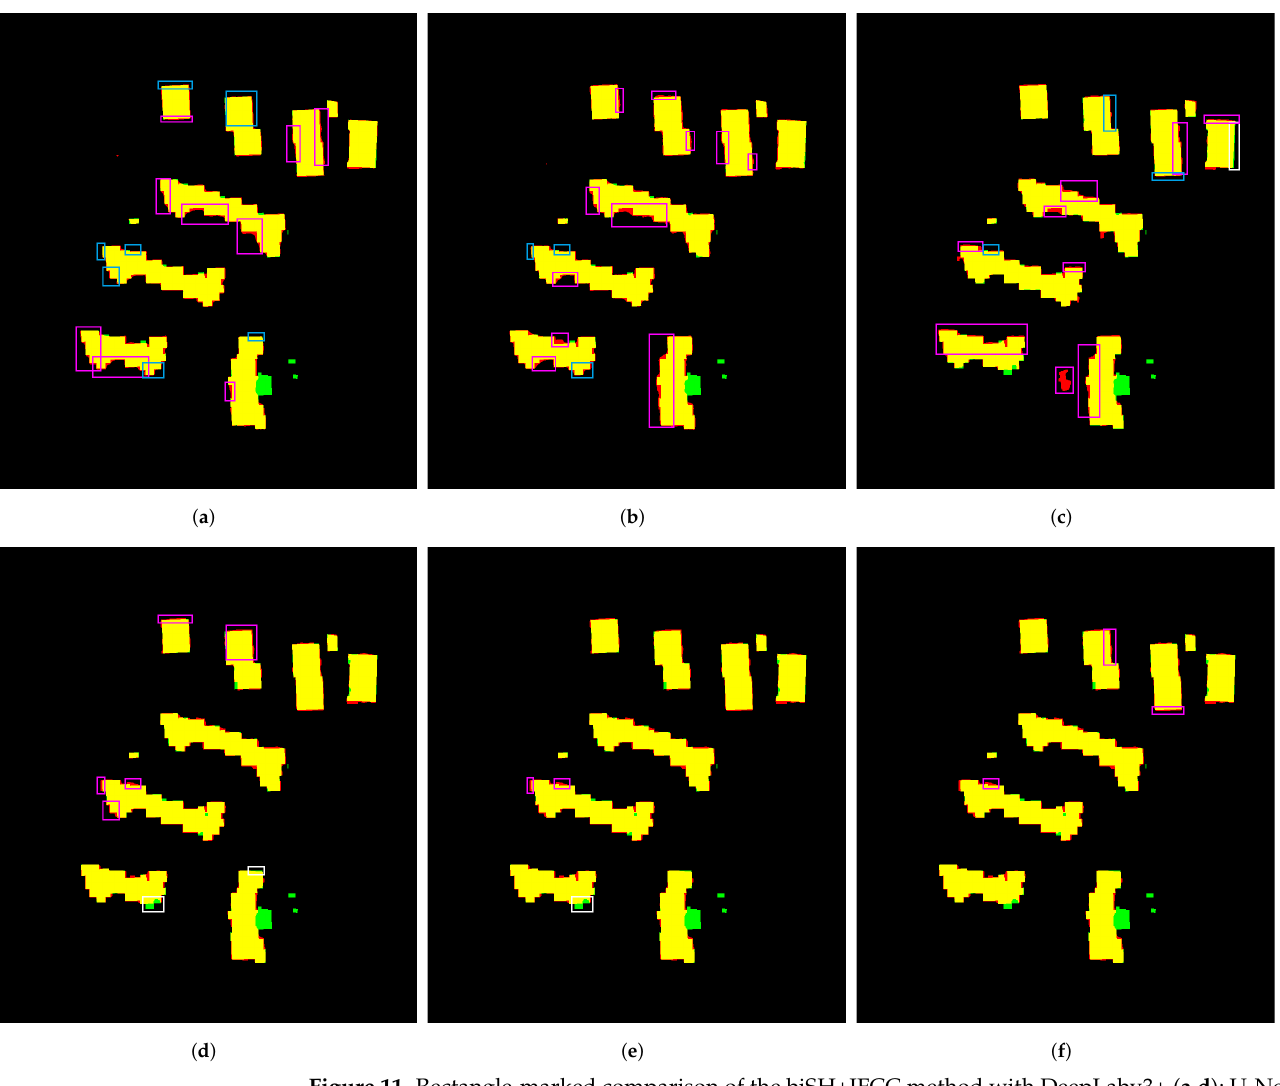
Figure 11. Rectangle-marked comparison of the biSH+IFCC method with DeepLabv3+ ( a , d ); U-Net ( b , e ); and the HOA method ( c , f ) on the second test area. In ( a – c ), the rectangles are drawn on the results of the compared methods, while in ( d – f ), the rectangles are drawn on the result of the biSH+IFCC